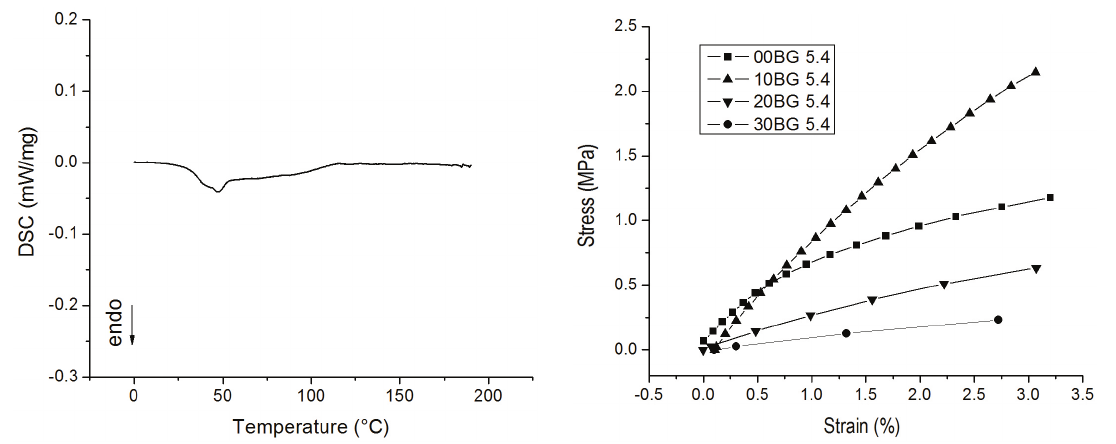
Figure 6. DSC graphic of PDLLA. Figure 7. Stress-strain curve for PDLLA/BG58S